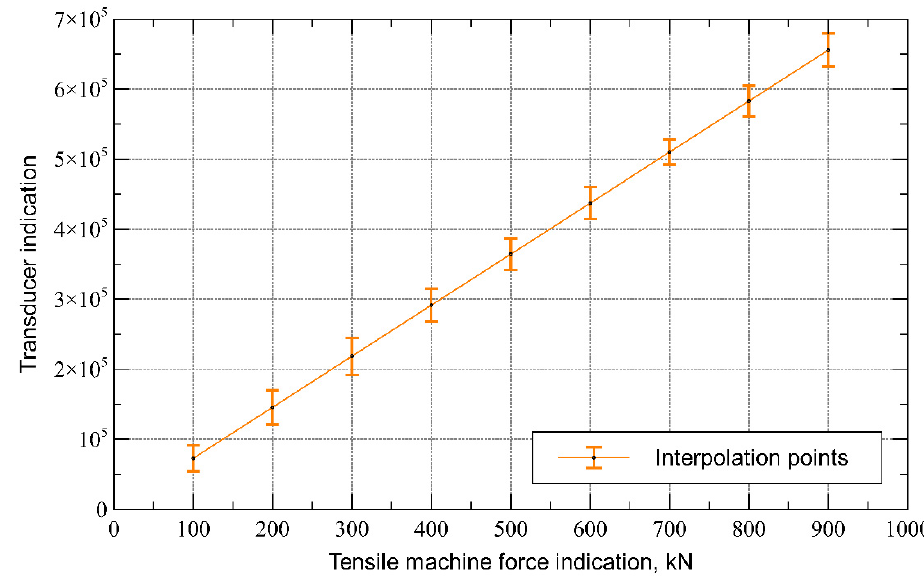
Figure 11. Linear regression of mean calibration results: measurement function.